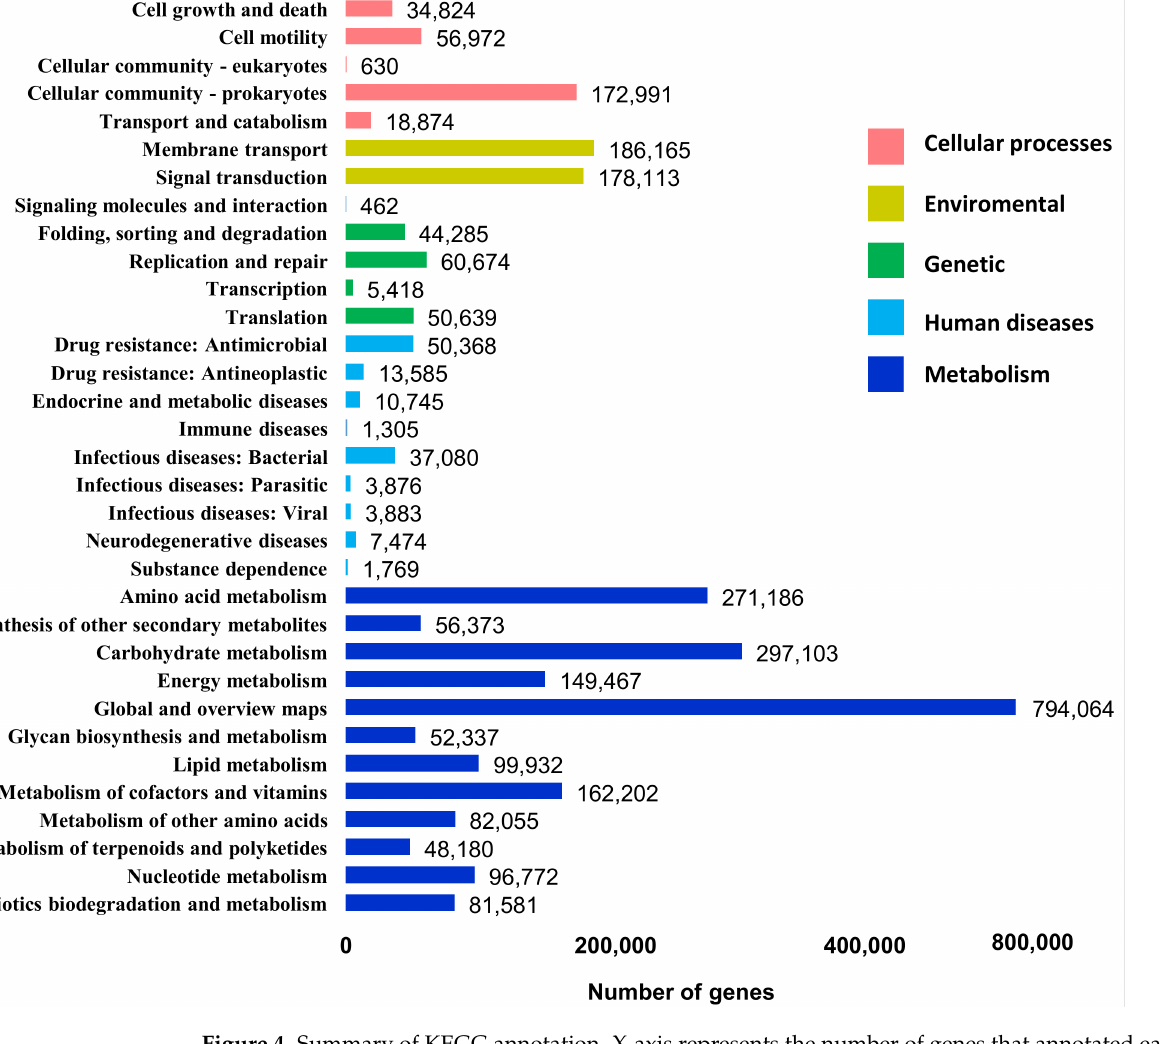
Figure 4. Summary of KEGG annotation. X-axis represents the number of genes that annotated each pathway, and y-axis lists annotated pathways in the particular